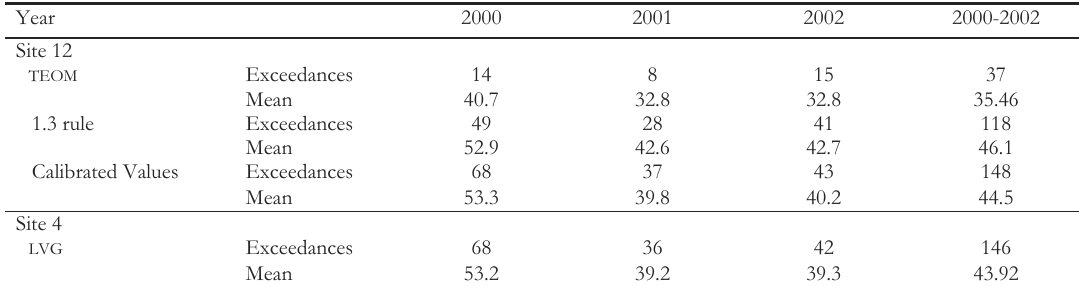
Number of exceedances and predicted annual